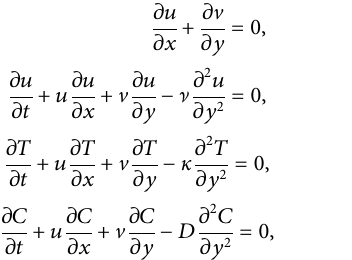
Velocity pro fi les ( S (cid:1) 2 . 10 − 2 . 30 ) .